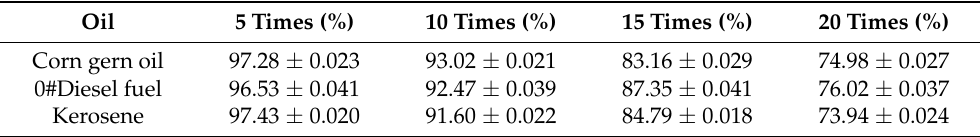
Table 3. Oil-water separation efficiency after multiple cycles of PDMS@Fe 3 O 4